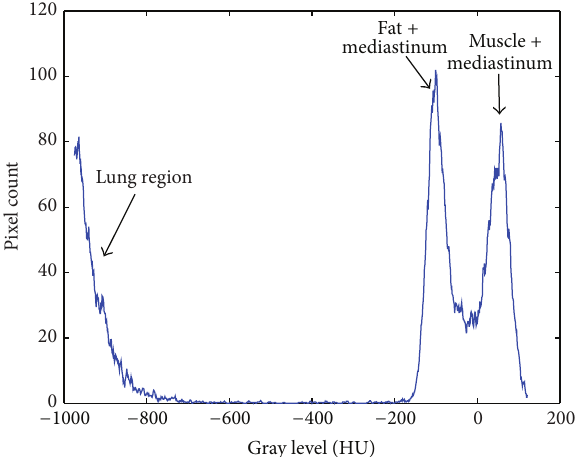
Figure 3: Histogram of the Wiener-filtered image.